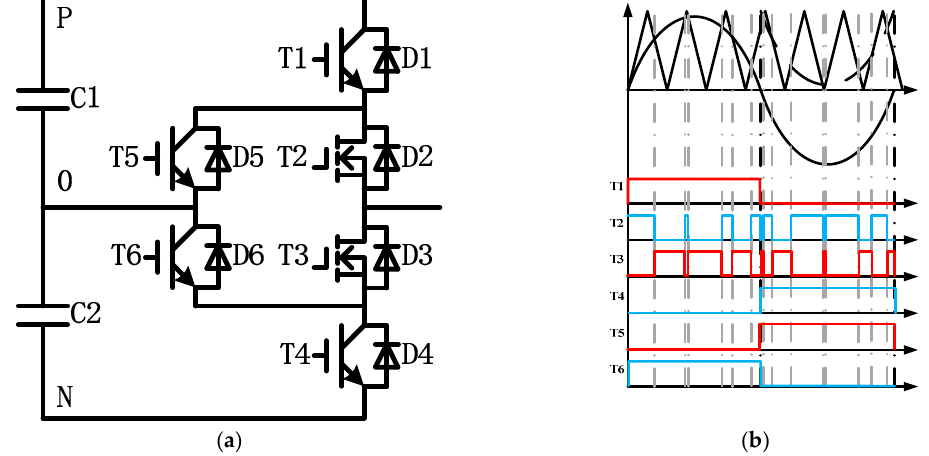
Figure 7. ( a ) ANPC topology based on the SiC&Si hybrid module; ( b ) driving waveform of each tube under SPWM2 modulation.